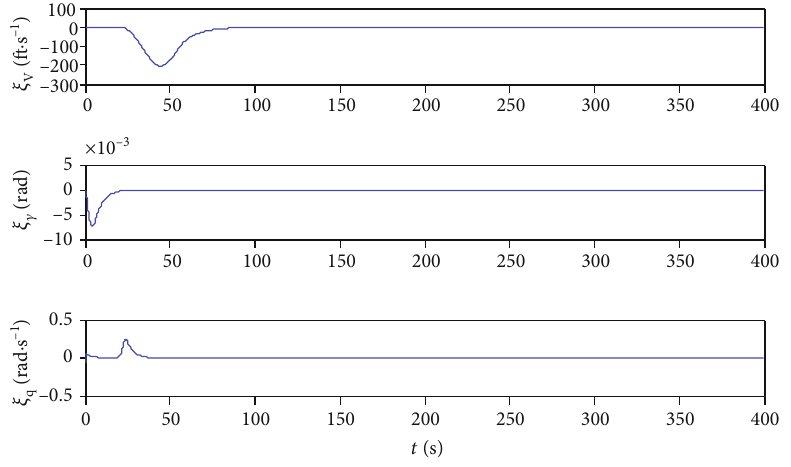
Figure 12: Curves of auxiliary